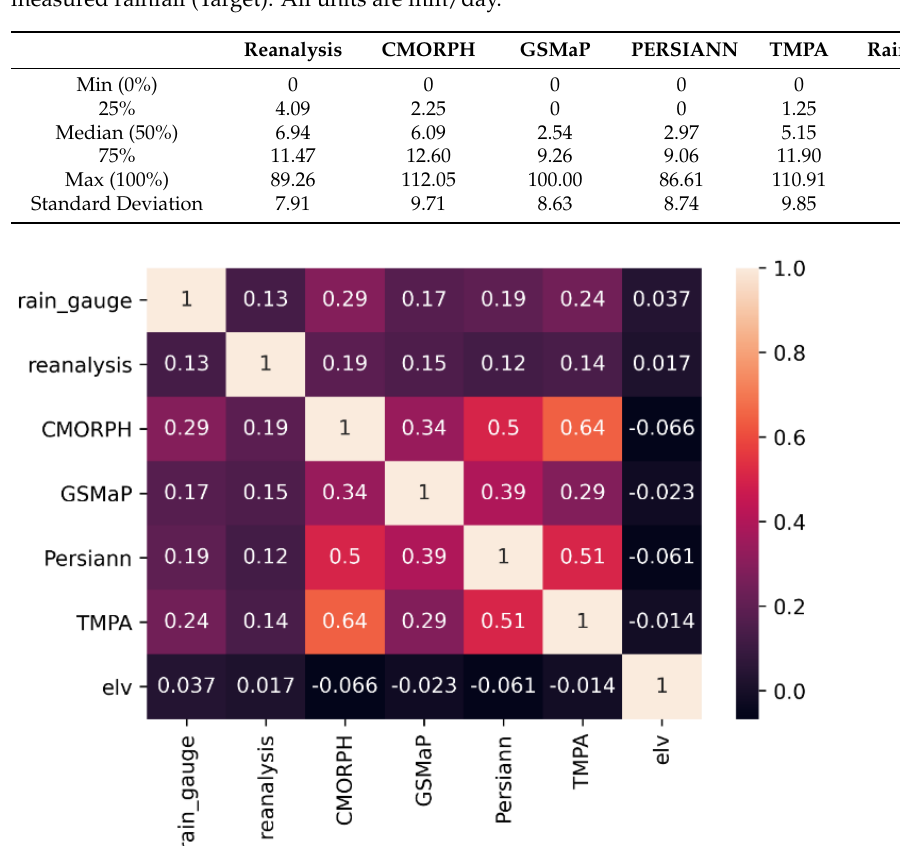
Table 2. Percentiles and standard deviations of rainfall prediction from models as well as the meas- ured rainfall (Target). All units are mm/day.